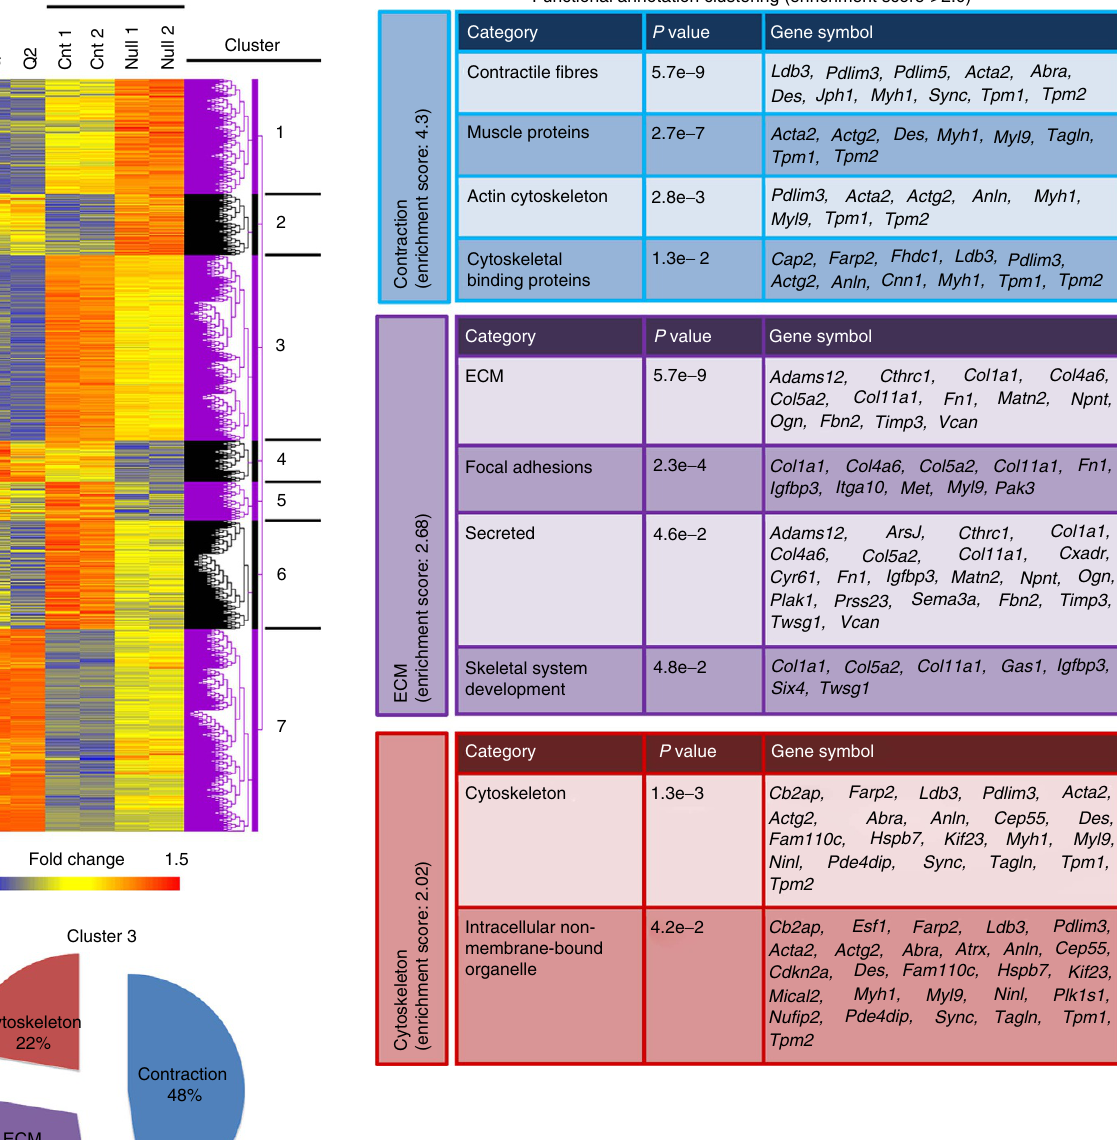
cytoplasmic localization of total YAP-1 (Fig. 3h,i). YAP-1 functions